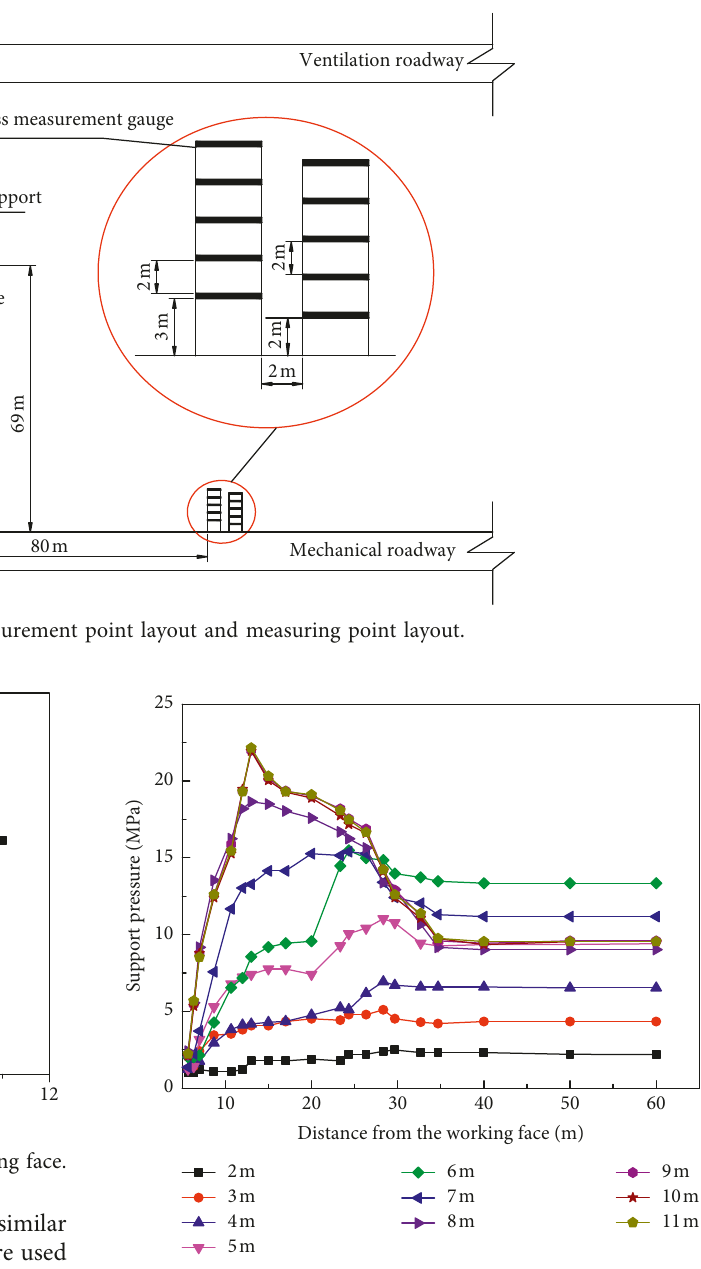
Figure 23: Distribution of advance bearing pressure at different measuring points in